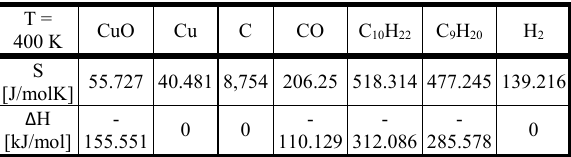
Table 3.Summary of the thermal parameter, necessary for the calculation of the